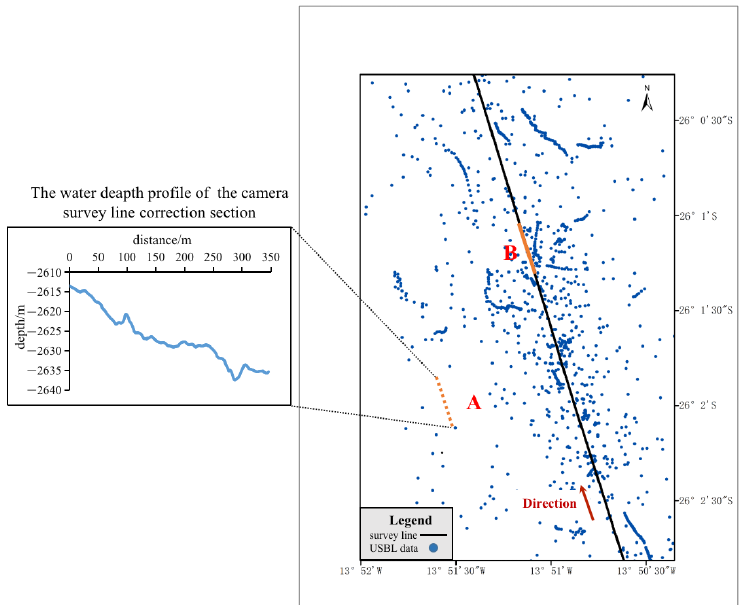
Figure 4. Schematic diagram of the textual method. (( A ) represents the camera line correction segment profile; ( B ) represents the ship position “baseline”).